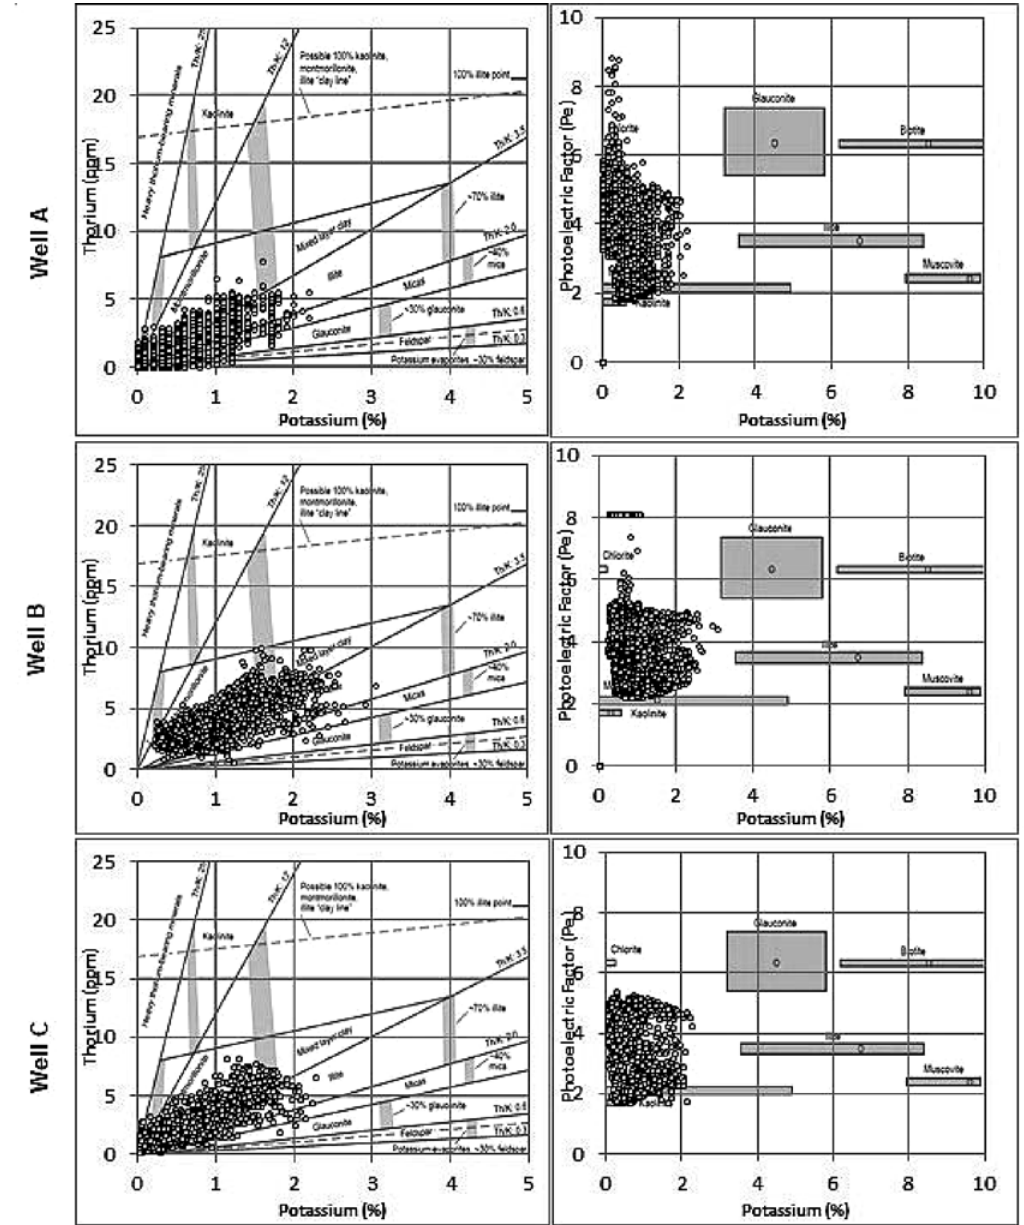
Fig. 1. Clay minerals identification cross plots of zones with Gamma-ray less than 50